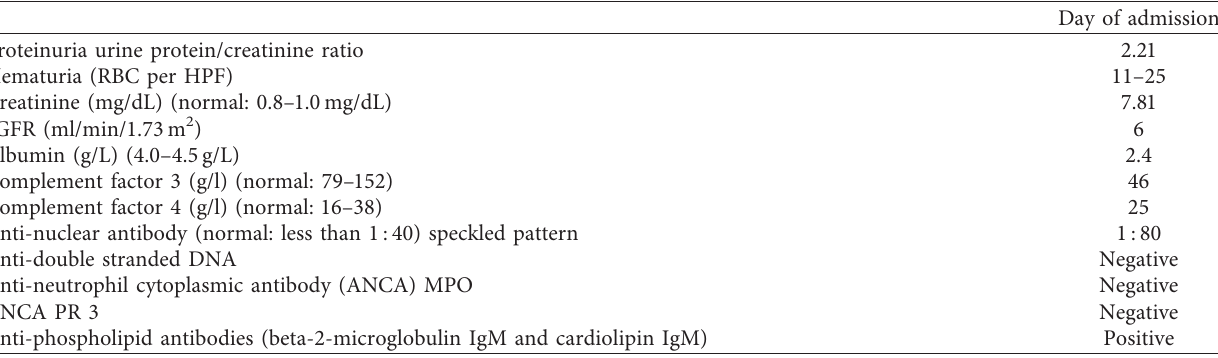
Table 1: Results of laboratory investigations.